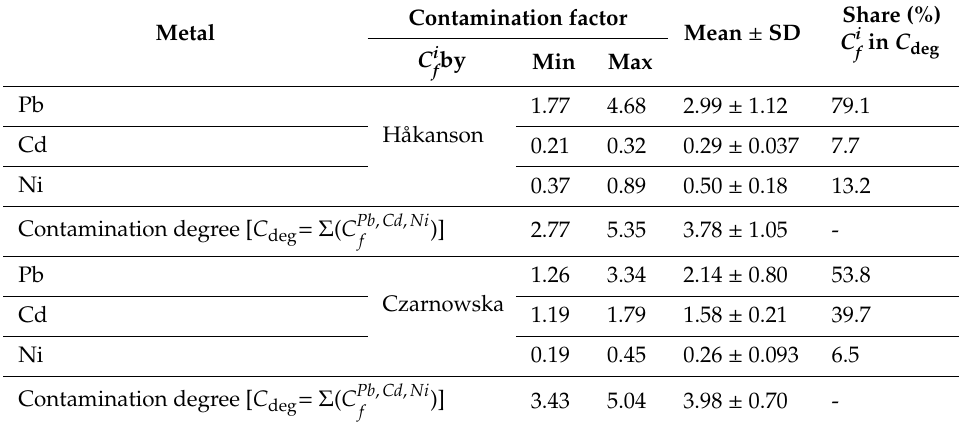
Table 7. Contamination factors and degrees for the particular heavy metals for the entire Kampinoski National Park (7 sites, Figure